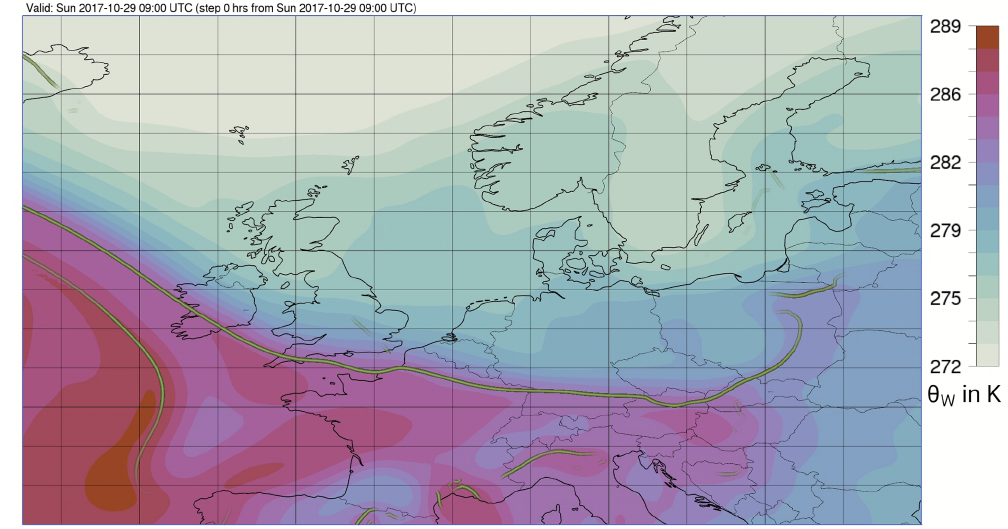
Figure D6. As in Fig. D4 but for storm Herwart on 29 October 2017 at 09:00UTC.